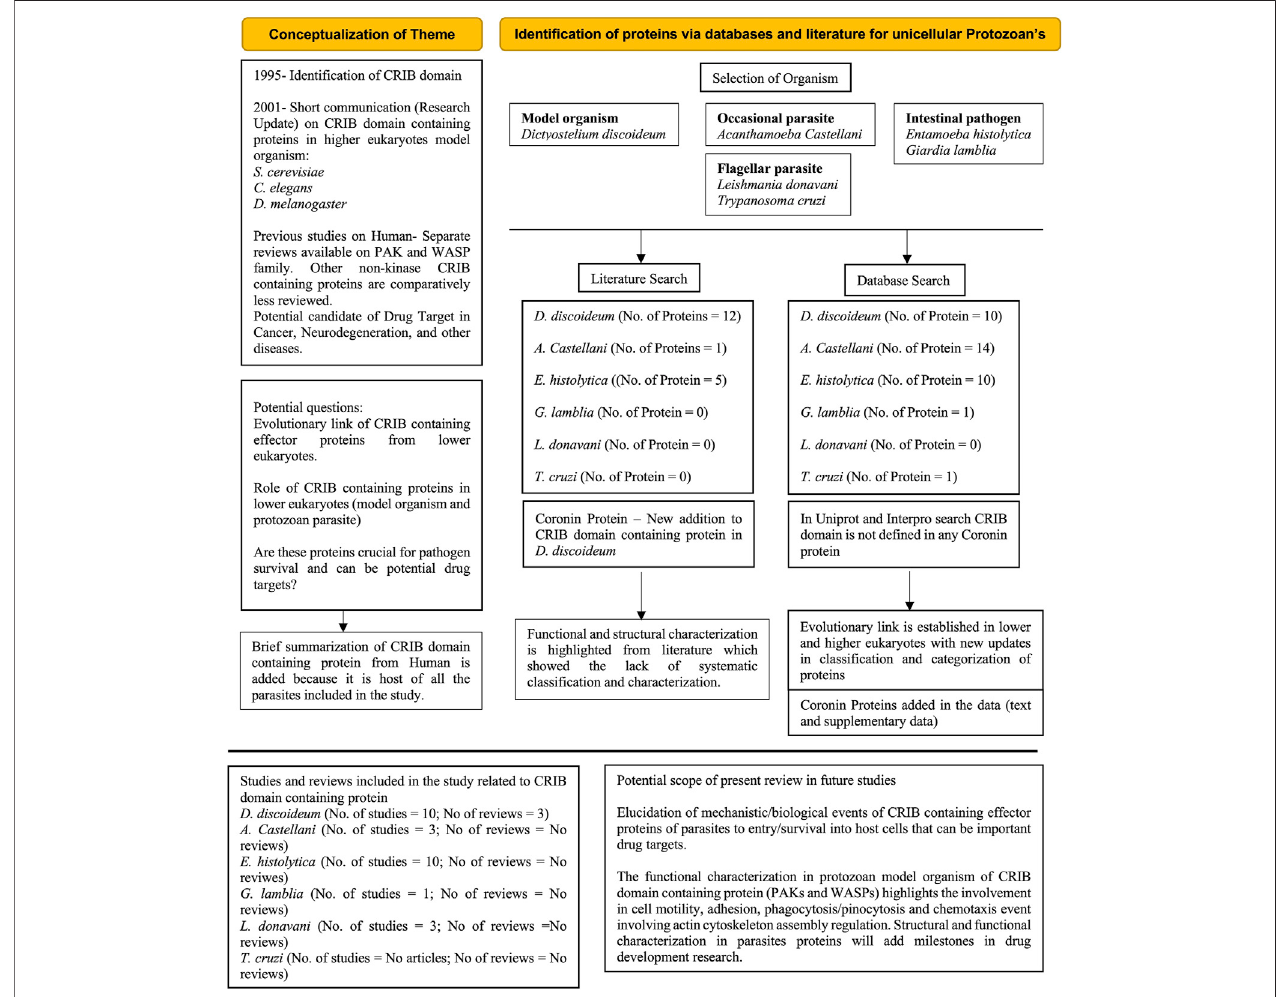
FIGURE6| PRISMA fl owdiagram(Reference)explainstheconceptualization,briefoverviewofdatabase andliterature searchandoutcomesofsystematicreview. The numbers of studies and reviews mentioned in box purely accounting CRIB containing proteins about particular organism. The future scope of systematic review explained in key bullets. Coronin proteins which are unique and proposed to be included in this review based on individual protein characterization (Protein ID ’ s are included in Supplementary Information ).